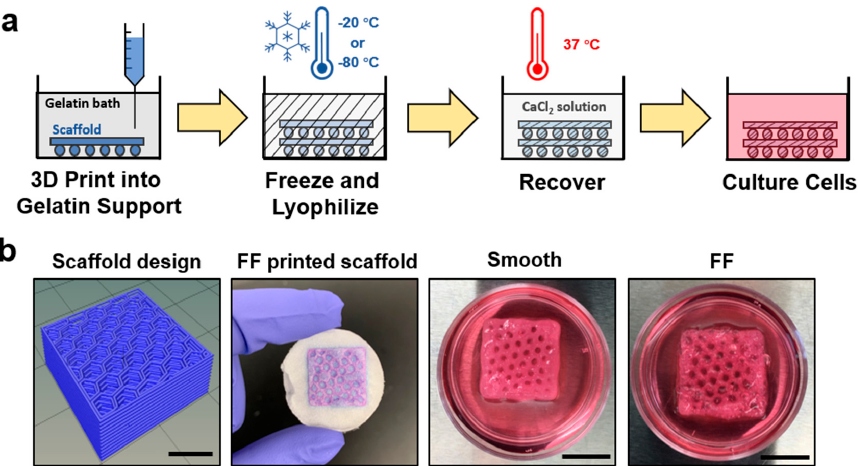
Figure 1. The Freeze-FRESH (FF) technique enables 3D printing of biomaterial scaffolds with hierarchical porosity. ( a ) A schematic illustration of the FF technique. ( b ) Comparison of the scaffold design, the FF scaffold in support bath after freezing and freeze drying, and the smooth and FF 3D printed scaffolds after recovery from the support bath. The recovered scaffolds were immersed in